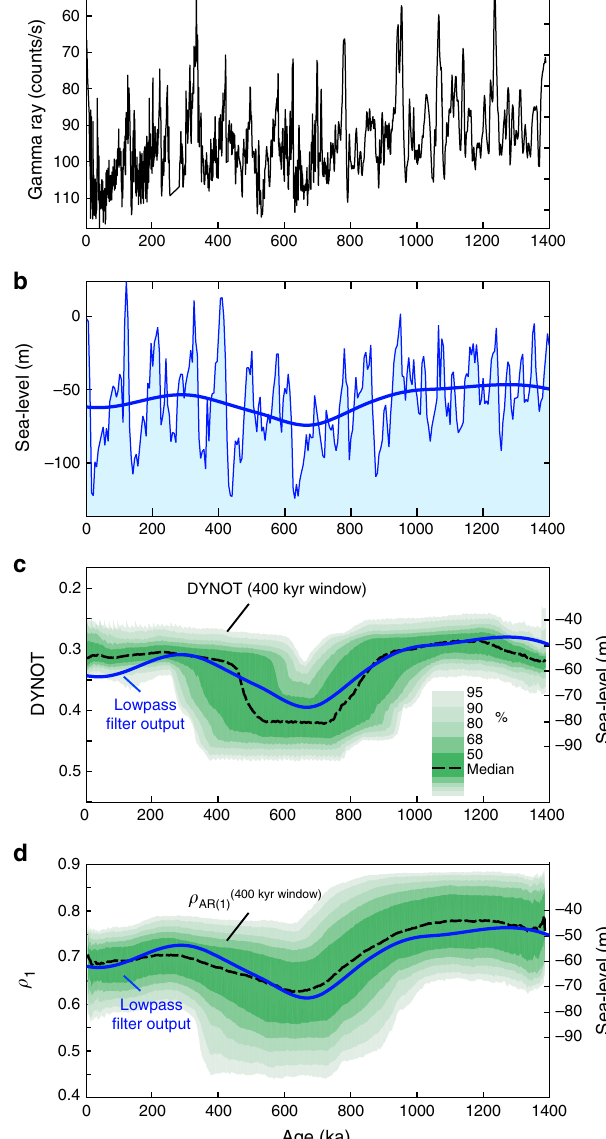
Fig. 3 Testing sedimentary noise models on the gamma ray log from ODP Site 1119. a Fine-tuned gamma ray series, with one outlier removed (see Supplementary Fig. 3). b Sea-level changes are estimated from benthic foraminiferal δ 18 O 2 shown with lowpass Gaussian fi lter output of